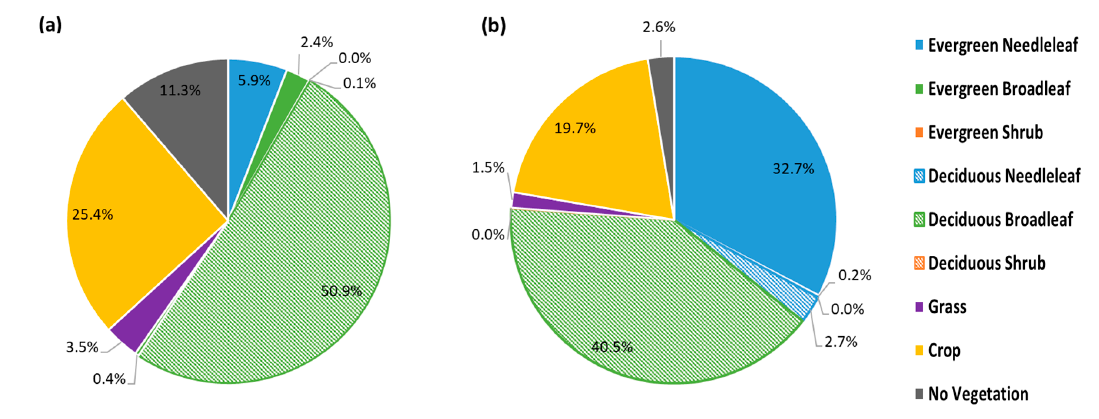
Figure 3. Plant Functional Type (PFT) distribution for South Korea: ( a ) Moderate Resolution Imaging Spectroradiometer (MODIS) PFT; ( b ) Local PFT.